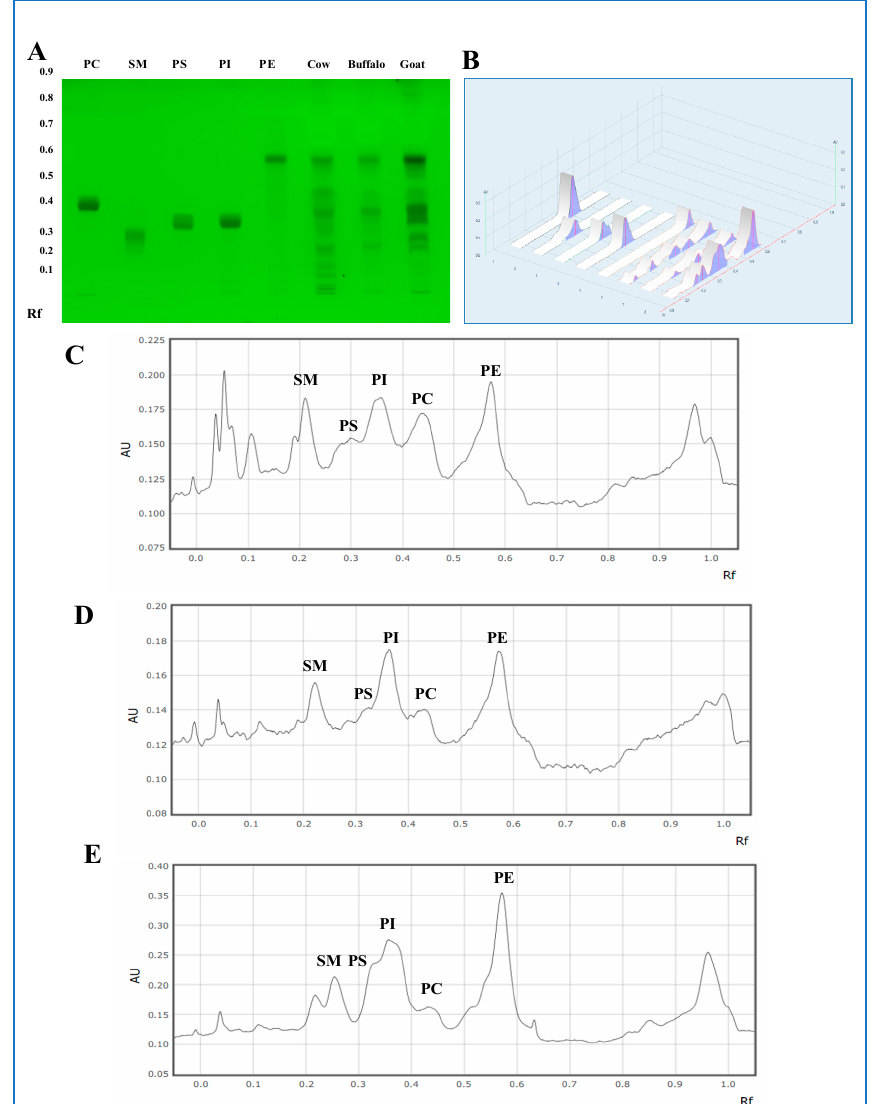
Figure 1. Analysis by high-performance thin-layer chromatography of ( A ) polar lipid standards and animal groups visualized under UV light at 254 nm after derivatization with iodine vapors. Polar lipid standards loaded at different volumes from track 1–5 and milk samples in track 6–8; ( B ) high-performance thin-layer chromatography 3-D densitogram; Chromatogram of ( C ) cow, ( D ) water buffalo, and ( E ) goat polar lipids. Representative image of three independent biological samples performed in